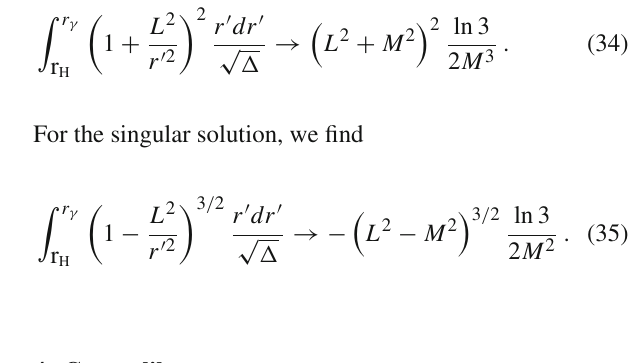
as a function of the black hole spin and for L varying from 0 to 1.6 in the regular black hole spacetimes. d As in c for the singular black hole solutions. In these plots we assume units in which M =